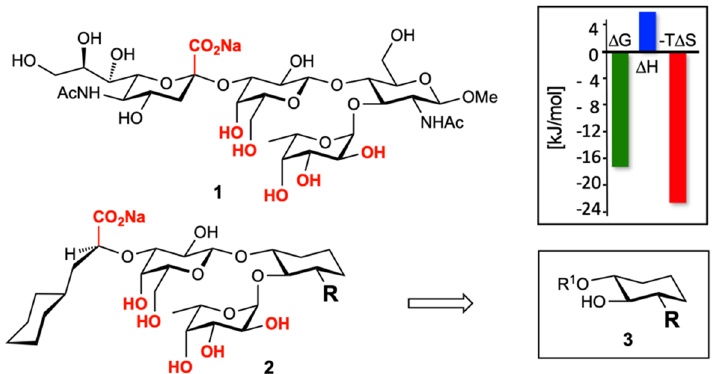
Figure 1. Selectin antagonists; the natural carbohydrate epitope sialyl Lewis x ( 1 , sLe x ) and its thermodynamic fingerprint upon binding to E–selectin, the family of mimetics 2 , and the Glc N Ac mimics 3 (R = H, alkyl, aryl). The pharmacophores in 1 and 2 are highlighted in red.